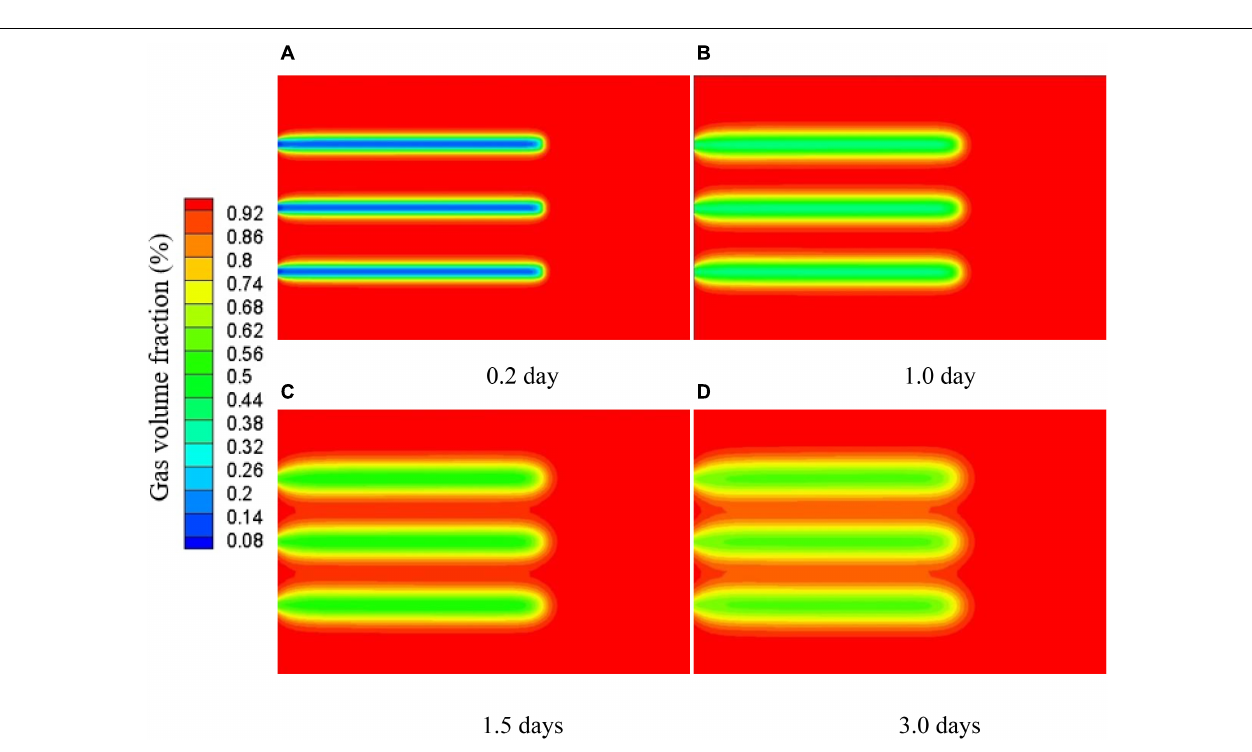
FIGURE 12 | Gas seepage fields of a 7.5-m slotted coal seam when λ = 0 . 1: (A) 2 day, (B) 1 day, (C) 1.5 days, and (D) 3